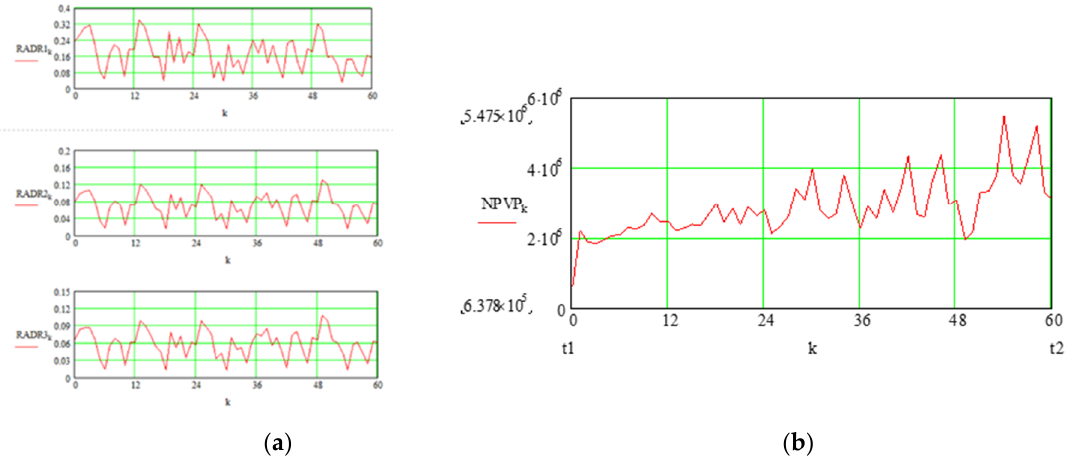
Figure 6. Graphical representation of the RADRs ( a ), and total NPV ( b ) dynamics for Scenario B3CD (m = 1, σ = 0.30; term structure of the interest rate considered; interest rate seasonal rate fluctuations considered).